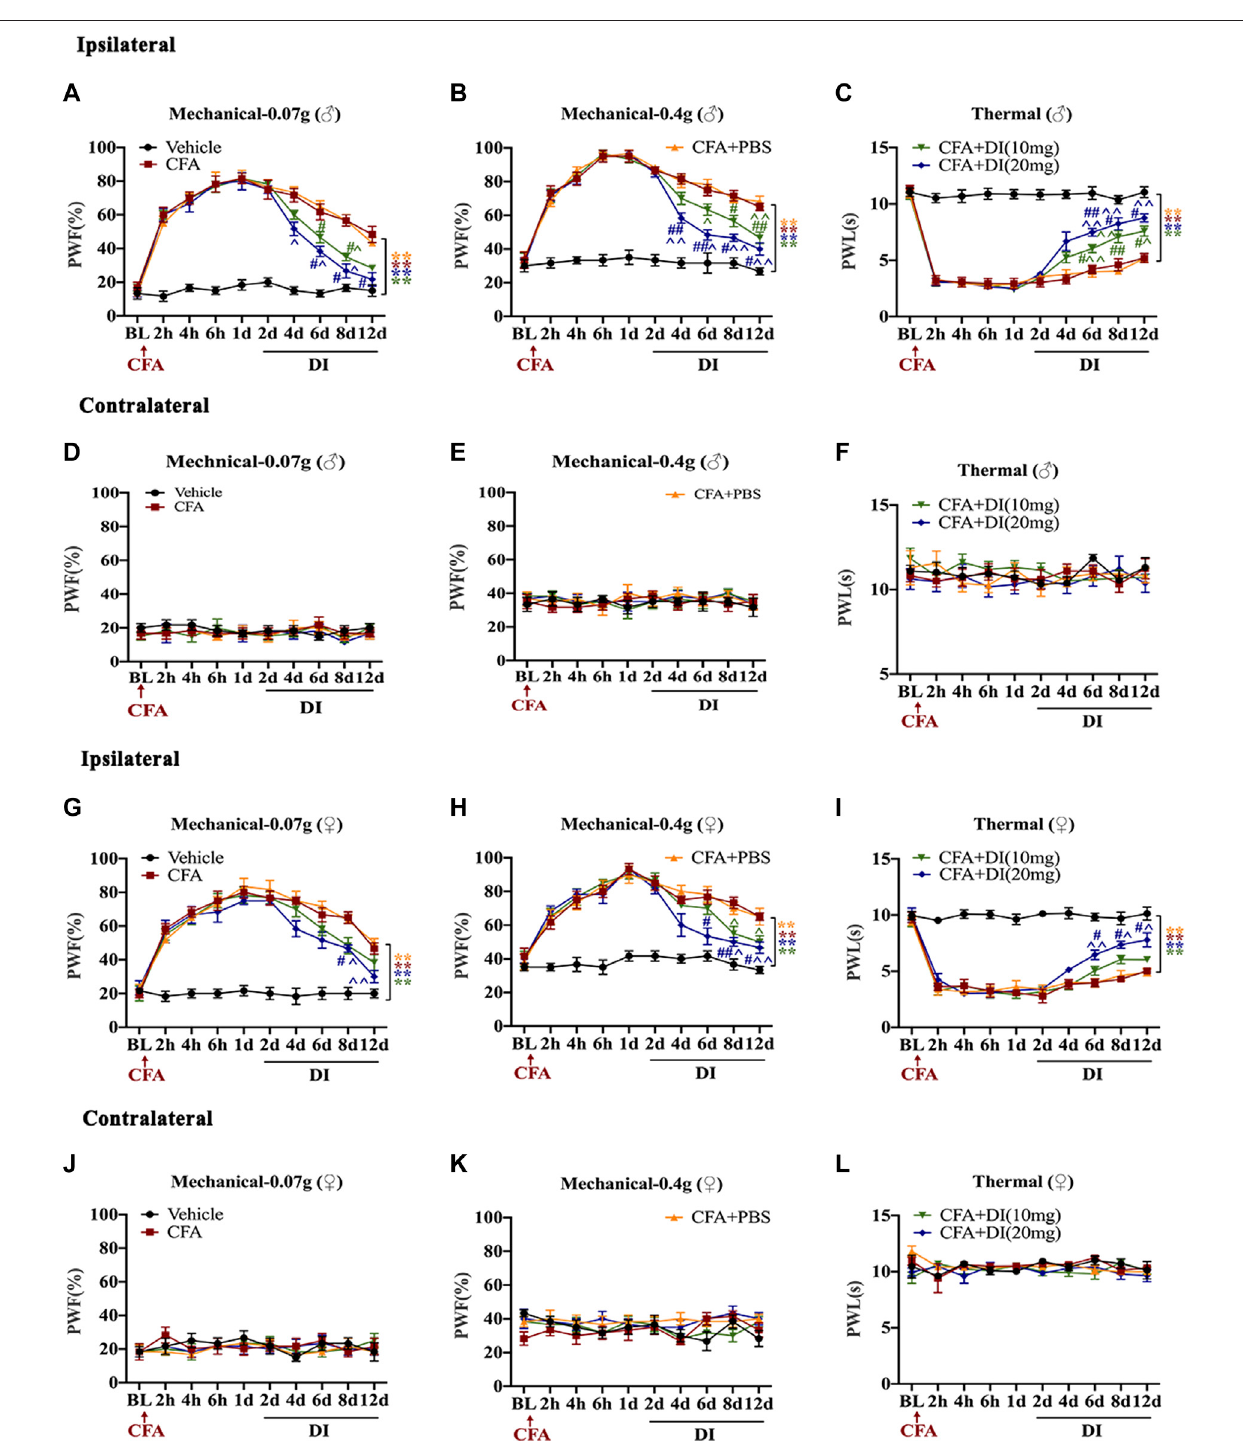
FIGURE 1 | Effects ofDI on CFA-induced mice in fl ammatorypain model. (A,B) The effect on mechanical allodynia (0.07 or 0.4 g) of the ipsilateral hind paw in male mice. F group (36, 200) = 9.377 for (A) , F group (36, 200) = 9.944 for (B) . (C) The effect on thermal hyperalgesia ipsilateral hind paw in male mice. F group (36, 200) = 13.93. (D – F) The effect of mechanical allodynia and hyperalgesia of the contralateral hind paw. F group (36, 200) = 0.3595 for (D) , F group (36, 200) = 0.3423 for (E) , F group (36, 200) = 0.5646 for (F) . (G – H) The effect on mechanical allodynia (0.07 or 0.4 g) of the ipsilateral hind paw in female mice. F group (36, 200) = 5.347 for (G) , F group (36, 200) = 4.478 for (H) . (I) The effect on thermal hyperalgesia ipsilateral hind paw in female mice. F group (36, 200) = 6.262. (J – L) The effect of mechanical allodynia and hyperalgesiaofthecontralateralhindpaw.F group (36,200)=0.4229for (J) ,F group (36,200)=0.9263for (K) ,F group (36,200)=1.391for (L) .Datavaluesareexpressedas mean ± SEM. N = 6 mice/group. ** p < 0.01 versus the vehicle group; # p < 0.05, ## p < 0.01 versus the CFA group; ˄ p < 0.05, ˄˄ p < 0.01 versus the CFA + PBS group.